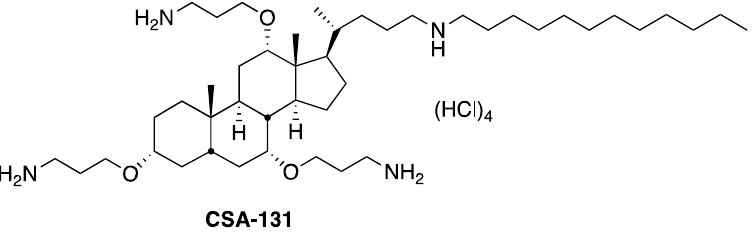
Figure 1. Structure of ceragenin CSA-131.